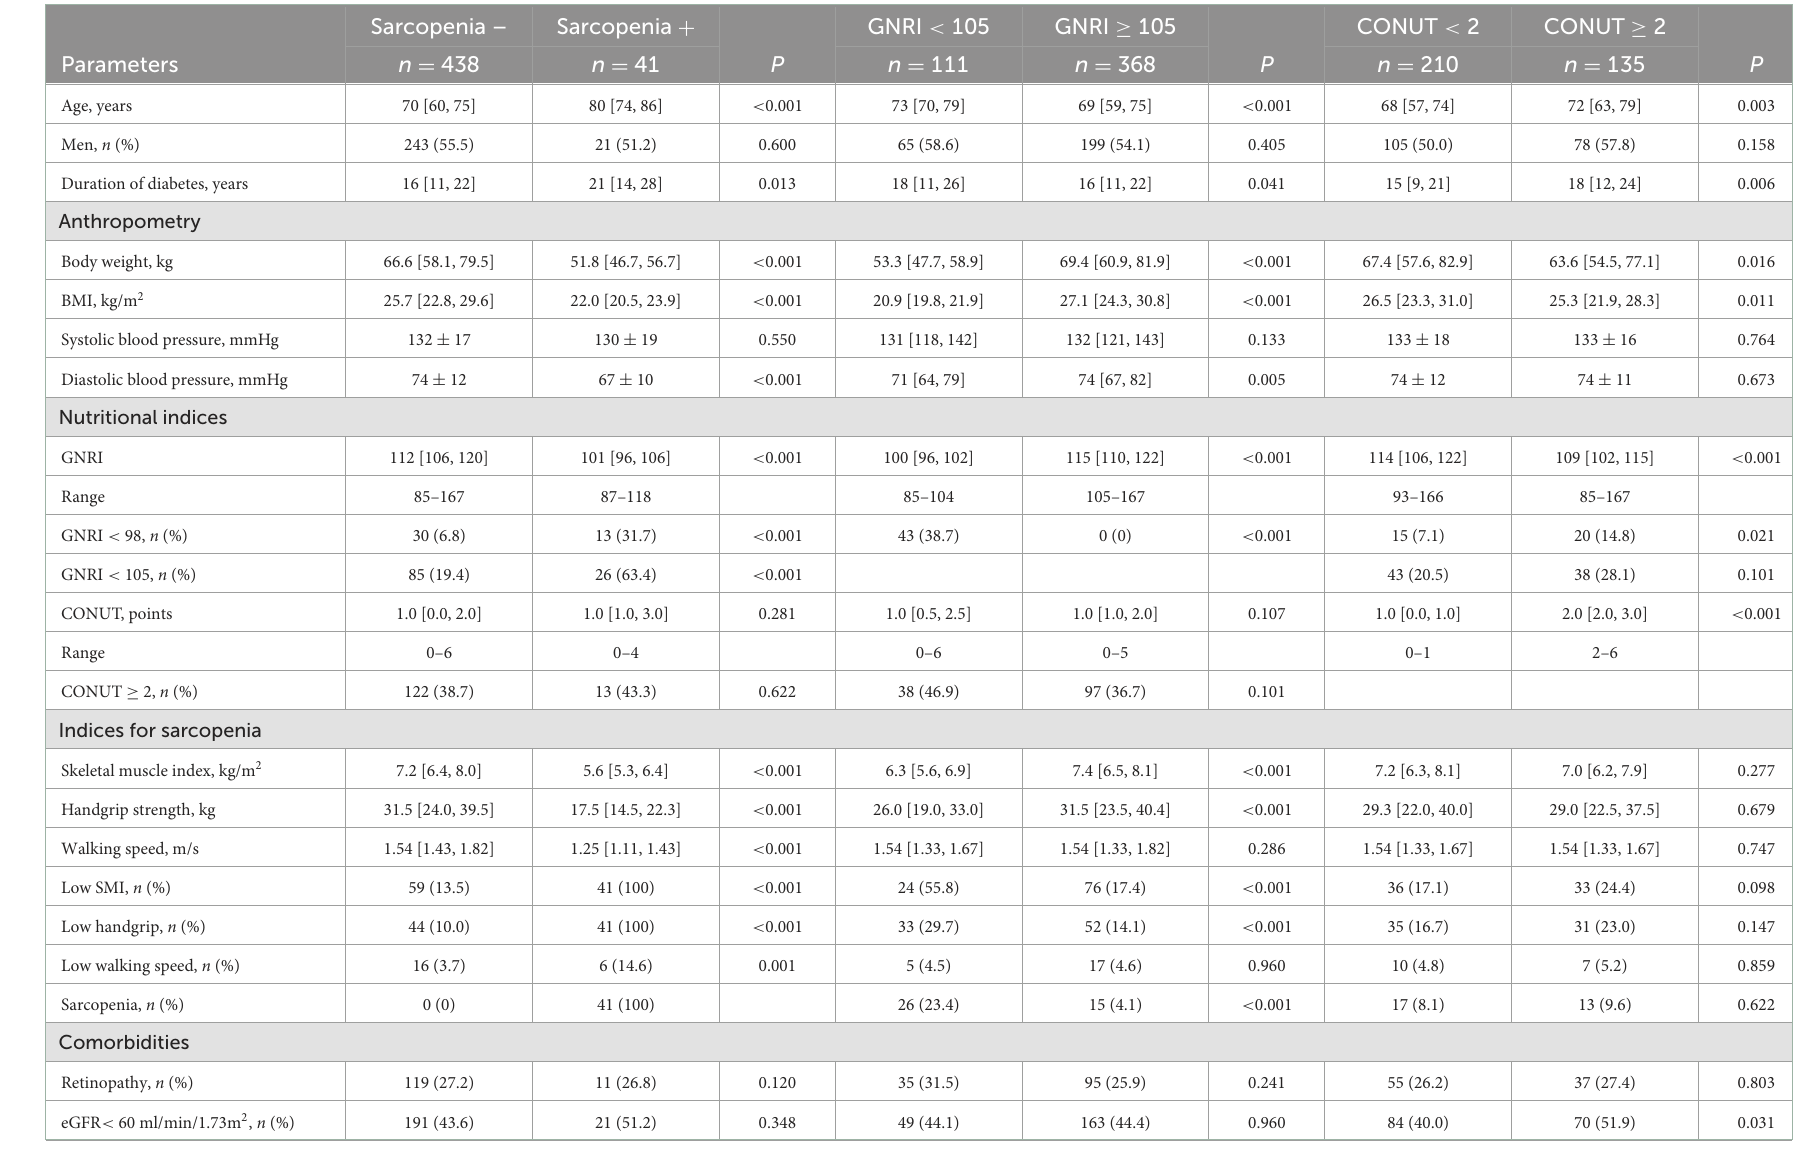
TABLE 2 General characteristics of participants with type 2 diabetes mellitus in the subgroups accordingly to sarcopenia, GNRI, and CONUT. Sarcopenia